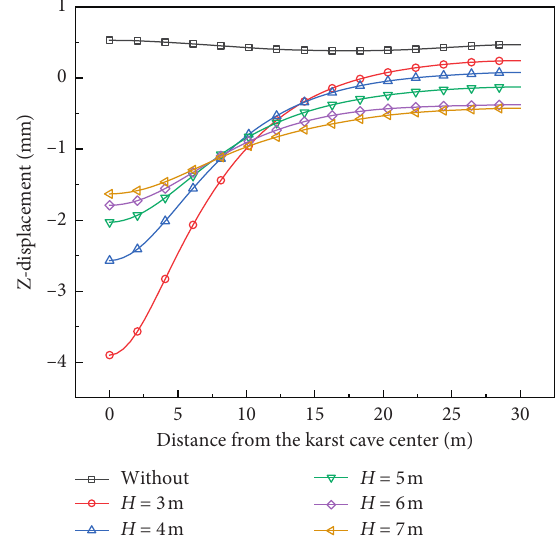
Figure 11: Z -displacement curves of tunnel vault with varying locations of the karst cave.